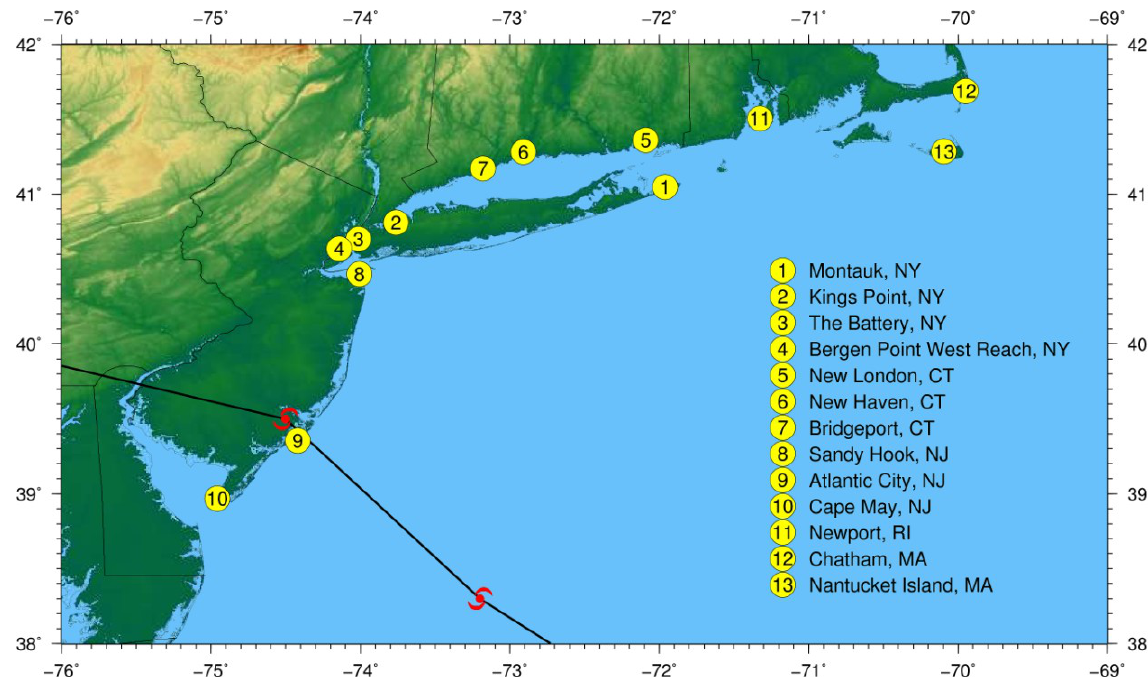
Figure 2. Map of NOAA tide gauge station